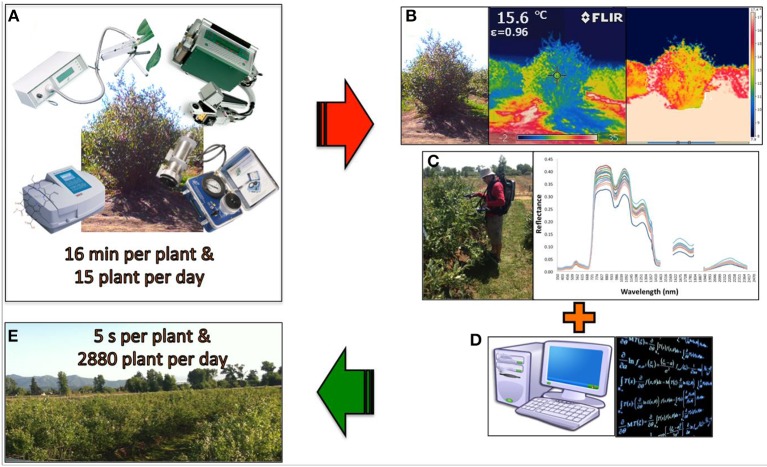
When drought or heat stress needs to be assessed, the evaluation window per day is reduced to 4 h. A basic physiological plant evaluation (gas exchange rate, stem water potential, chlorophyll fluorescence, and pigment concentration) (A) takes about 16 min per plant, representing a characterization of a maximum 15 genotypes per day. When thermography (B) and spectrometry (C) is considered, linear and non-linear modeling (D) can streamline the evaluation of plant status, further increasing the number of genotypes that can be evaluated in a breeding population per day (E).